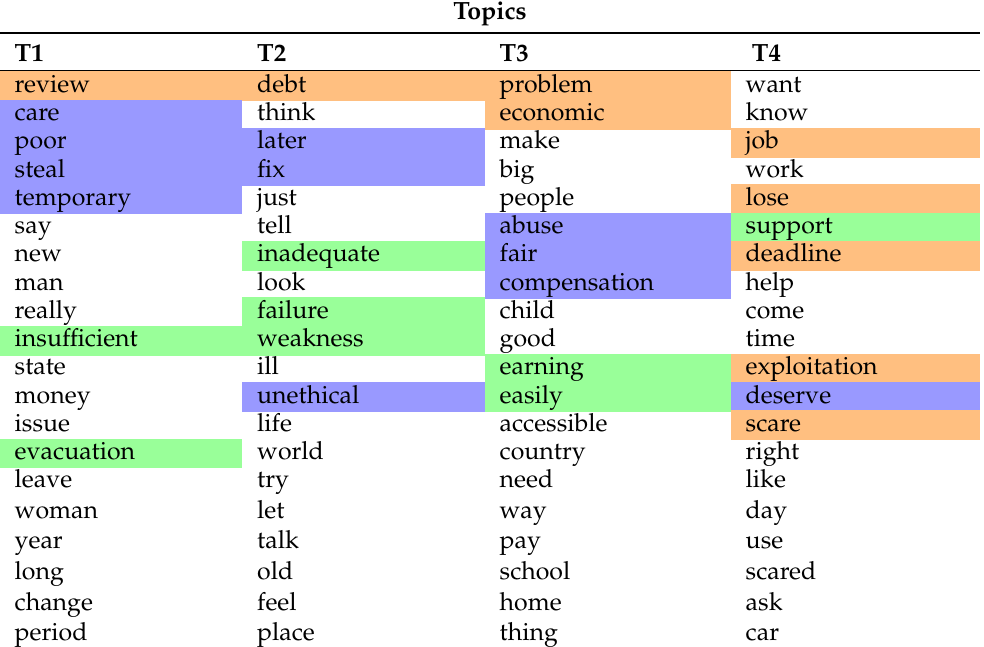
Table 5. Most prevalent words from each topic related to the fraud triangle in our data set. Words are colored orange, blue, and green, representing the vertices pressure, rationalization, and opportunity,